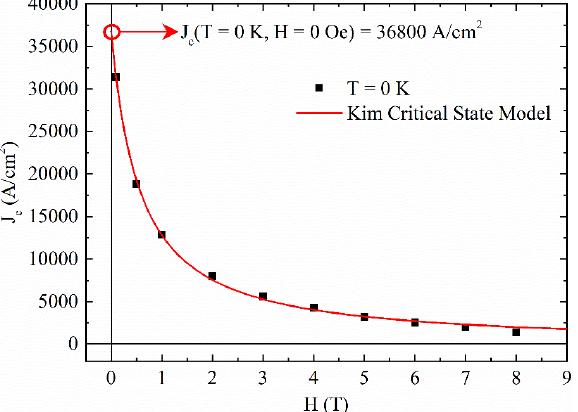
Figure 6. J c at T = 0 K as a function of the magnetic field has been reported together with the fit with the Kim critical state model (red solid line).